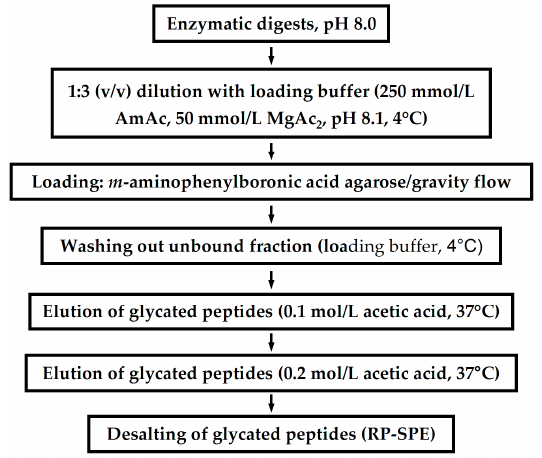
Figure 3. Enrichment of glycated (Amadori) peptides by BAC [127]. The experimental workflow relies on m -aminophenylboronic acid-agarose, filled in polypropylene columns, and gravity flow design.